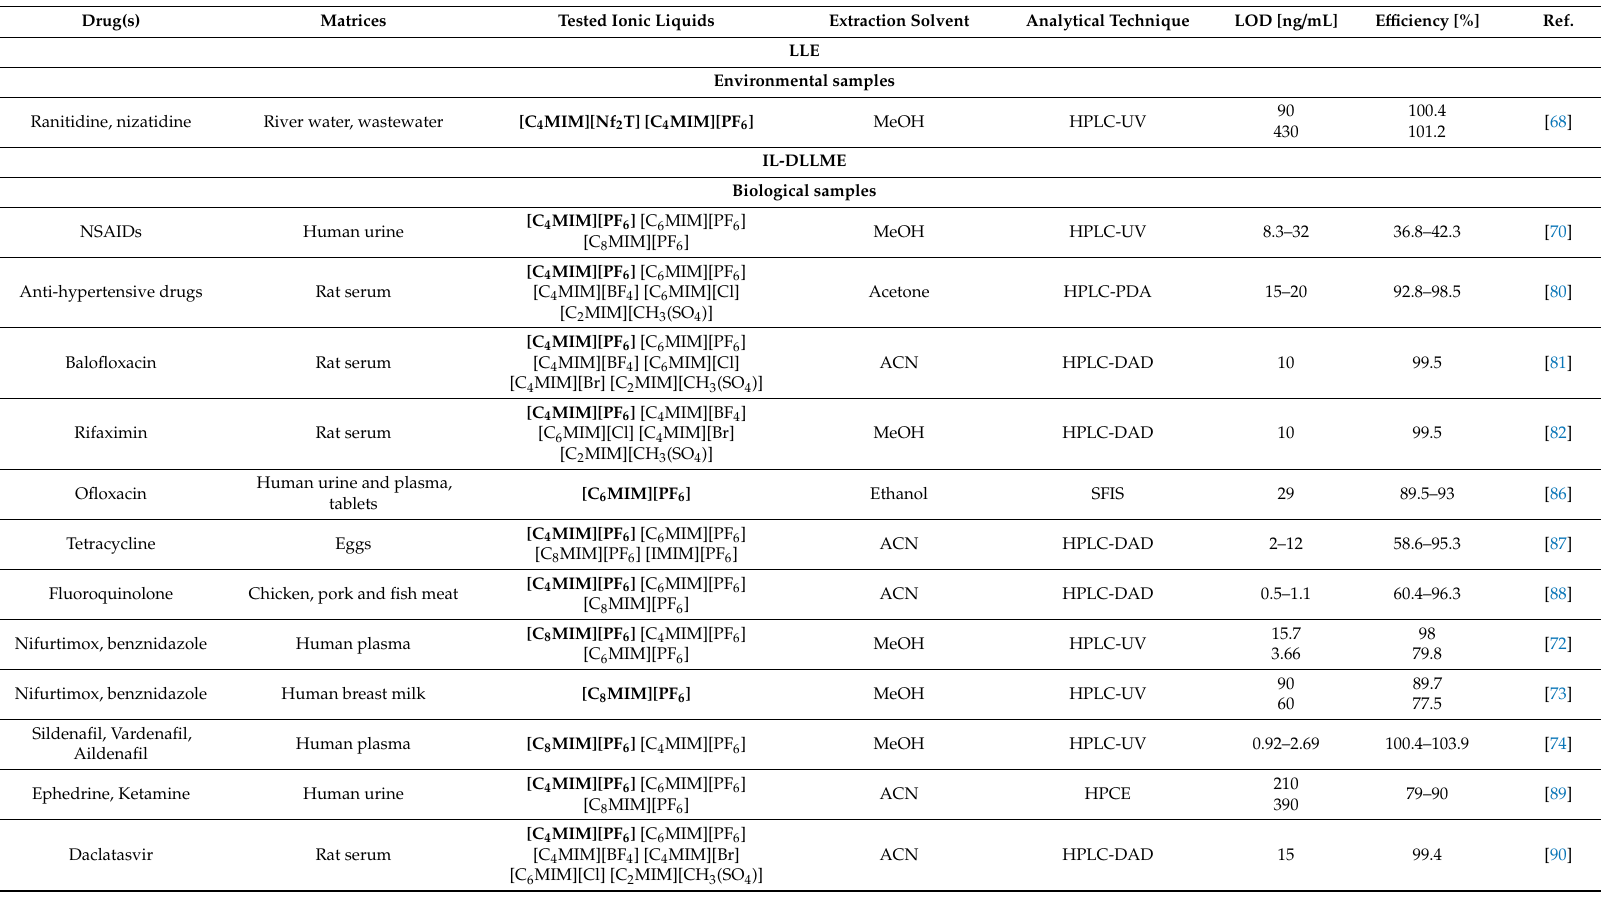
Table 2. Summary of the IL applications in liquid-phase microextraction drugs from biological and environmental